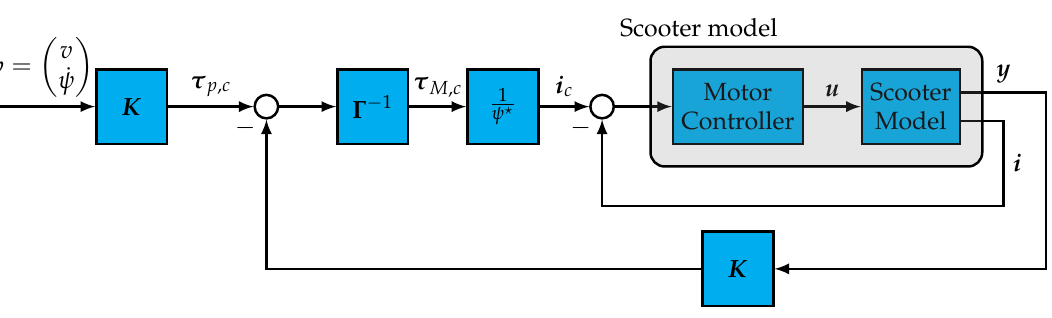
Figure 24. Schematic of the closed loop